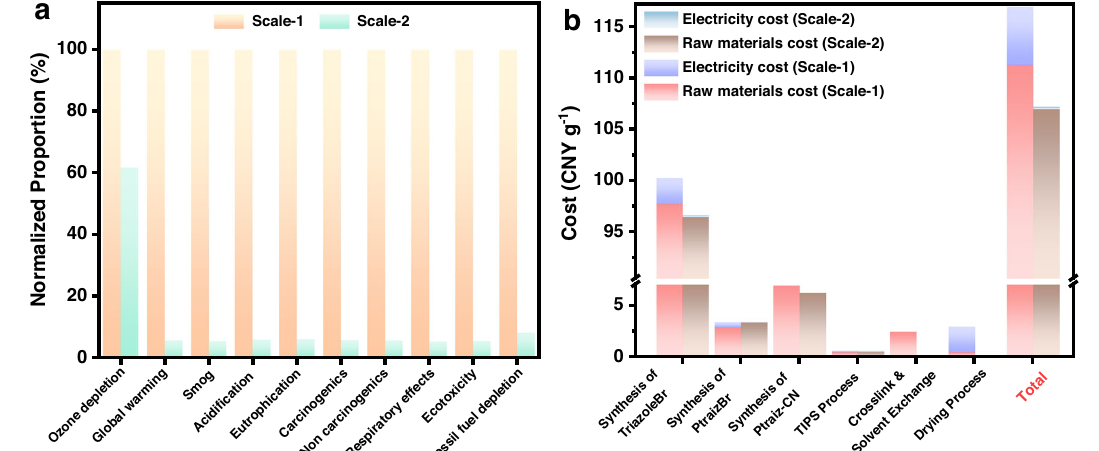
Fig. 6 | LCAand cost analysis.a Relativeenvironmentalimpacts of 1g Ptriaz-CN-A production at different preparation scales. The higher environmental impact in each category is normalized. b Production cost distribution of raw materials, electricity in each step for the synthesis of 1g Ptriaz-CN-A at different preparation